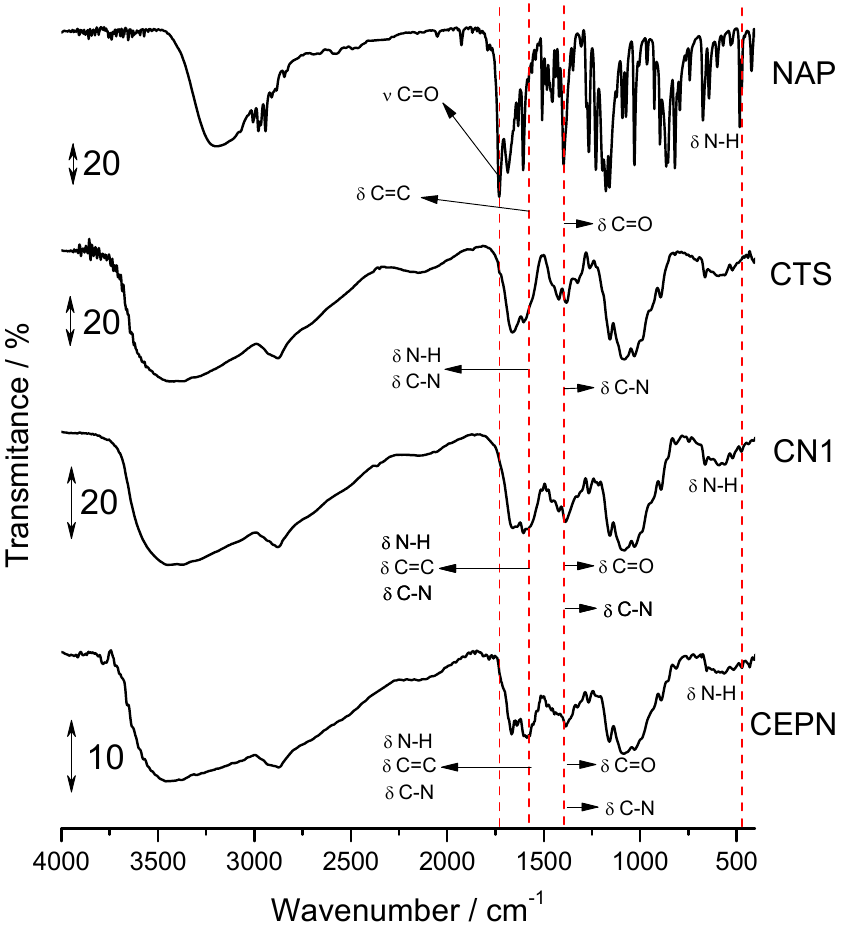
Figure 2. FTIR spectra of CTS, NAP, CN1 and CEPN.